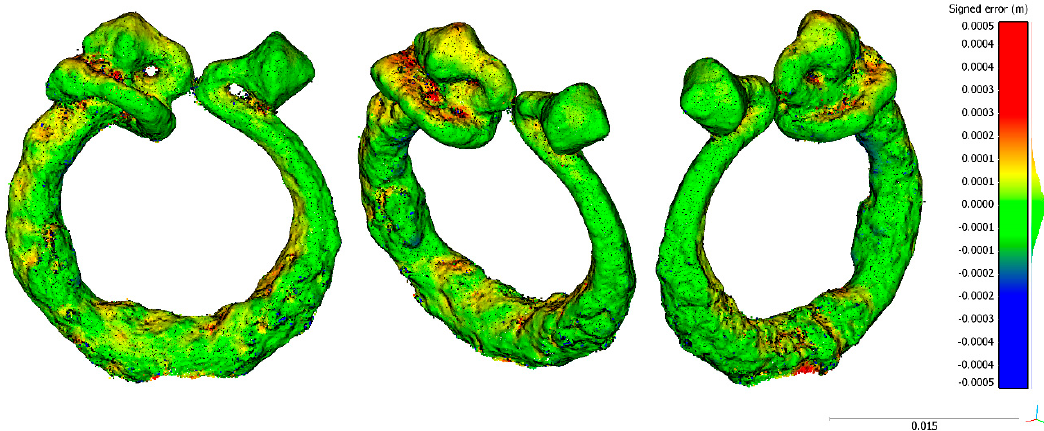
Figure 11. Different views of the spatial distribution of discrepancies between zoom lens reconstruction versus macro lenses for the specimen S2 (brooch): front view ( left ); front isometric view ( center ); and back isometric view ( right ).